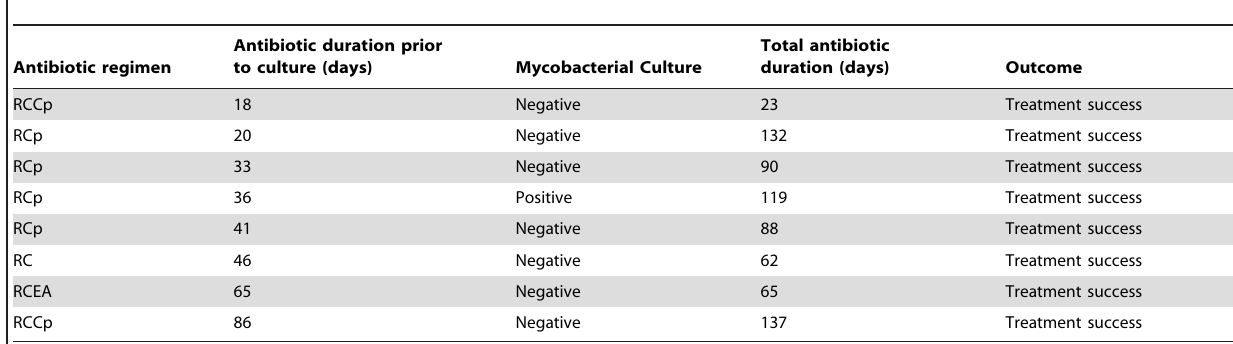
Table 4. Mycobacterial culture results for specimens after . 14 days of antibiotics prior to surgical excision.